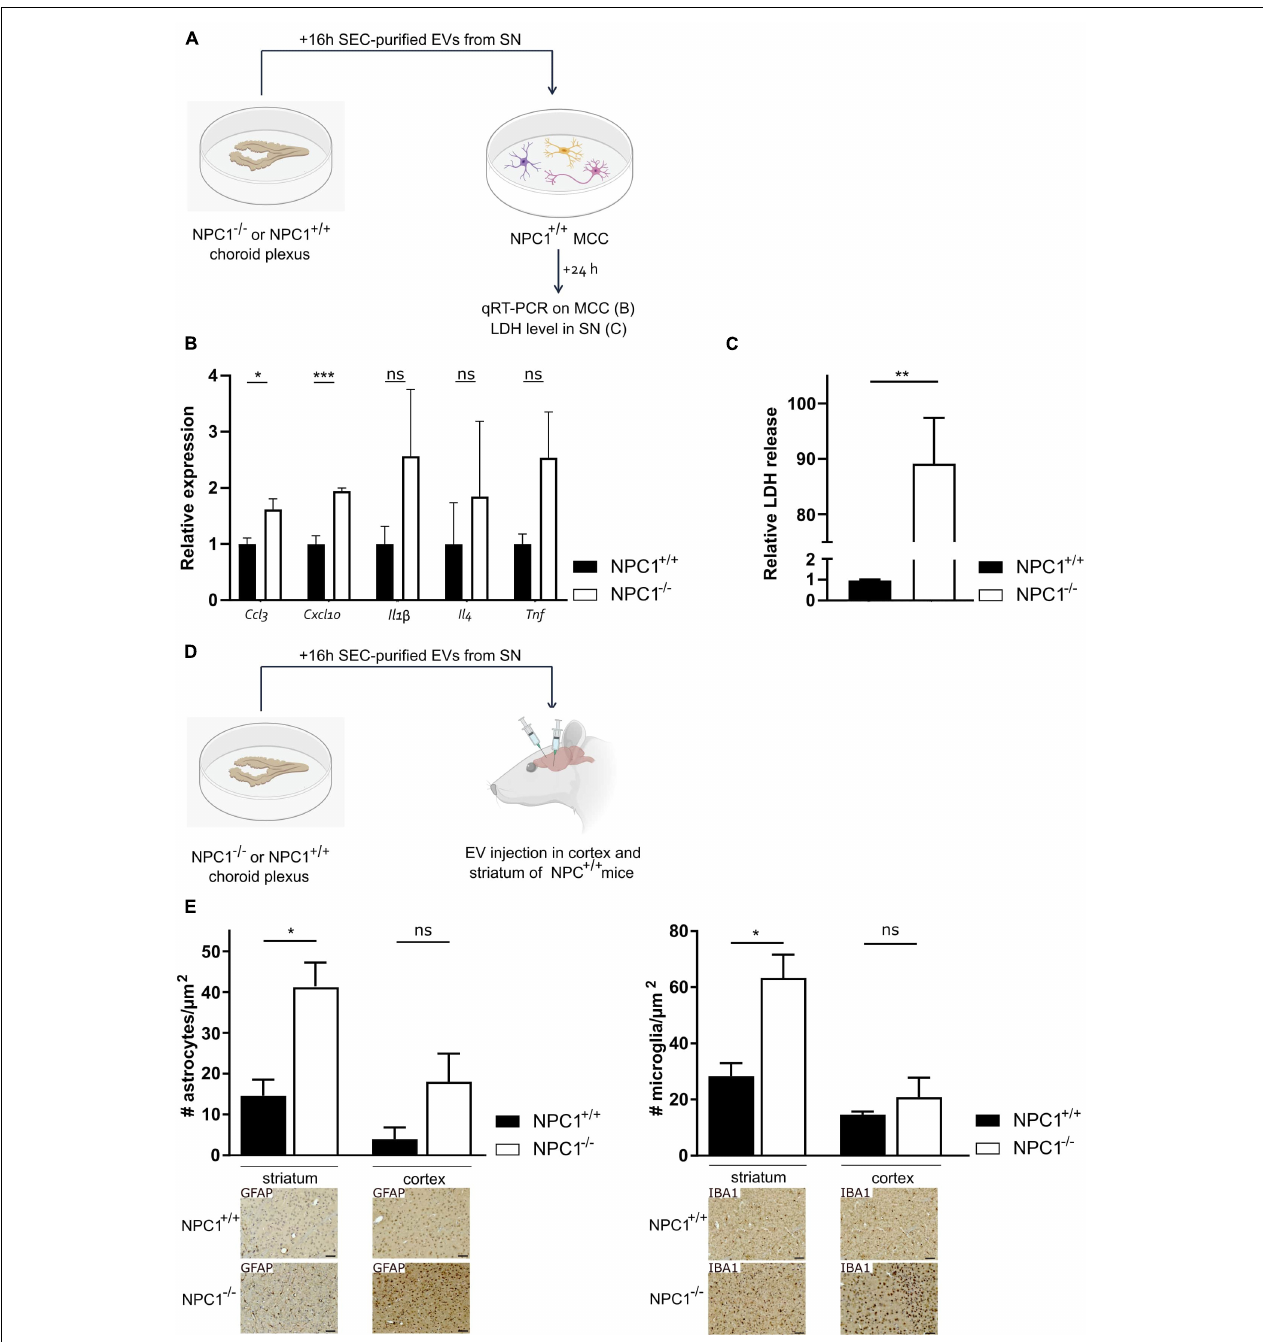
FIGURE 5 | Extracellular vesicles (EVs) isolated from choroid plexus explants of NPC1 − / − mice have toxic effects on the brain. (A) Overview of the experimental setup. Choroid plexus explants were isolated from of 9 weeks old NPC1 + / + and NPC1 − / − mice ( n = 5) and cultured for 16 h in Opti-MEM, after which the supernatant was collected followed by EV purification. MCCs were incubated with size exclusion chromatography (SEC) purified EVs separated from the secretome of the choroid plexus explants. 24 h after incubation qRT-PCR was performed on the MCC (B) and supernatant was collected and analyzed for LDH levels (C) . (D) Overview of the experimental setup. choroid plexus explants were isolated from 9 weeks old NPC1 + / + and NPC1 − / − mice ( n = 3) and cultured for 16 h in Opti-MEM, after which the supernatant was collected. SEC-purified EVs separated from the secretome of choroid plexus explants were injected in the striatum or cortex of NPC1 + / + mice followed by analysis 3 days later. (E) Quantification of IBA1+ (microglia) and GFAP+ (astrocytes) cells per µ m 2 in brain sections of wild type mice injected with EVs isolated from NPC1 + / + or NPC1 − / − choroid plexus explants. Representative images are shown below the graphs. Scale bar represents 20 µ m. Data are shown as a mean ± SEM. Statistical analyses on datasets were performed by Mann–Whitney test in panels (B,C) and t -test in panel (E) . Asterisks indicate statistical significance (* p < 0.05, ** p < 0.01, *** p < 0.001, ns: non-significant).